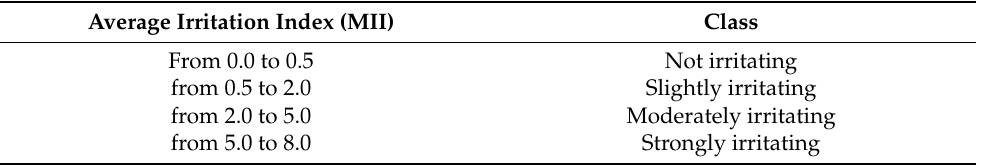
Table 2. Product classification based on the medium irritation